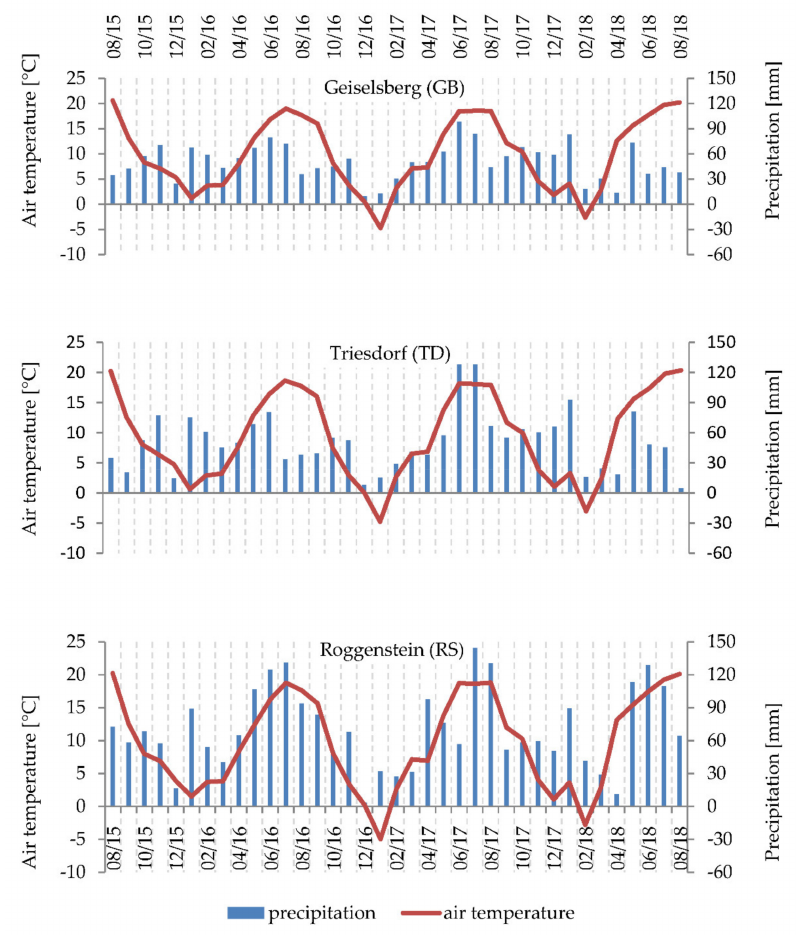
Figure 2. Weather conditions during trial period by